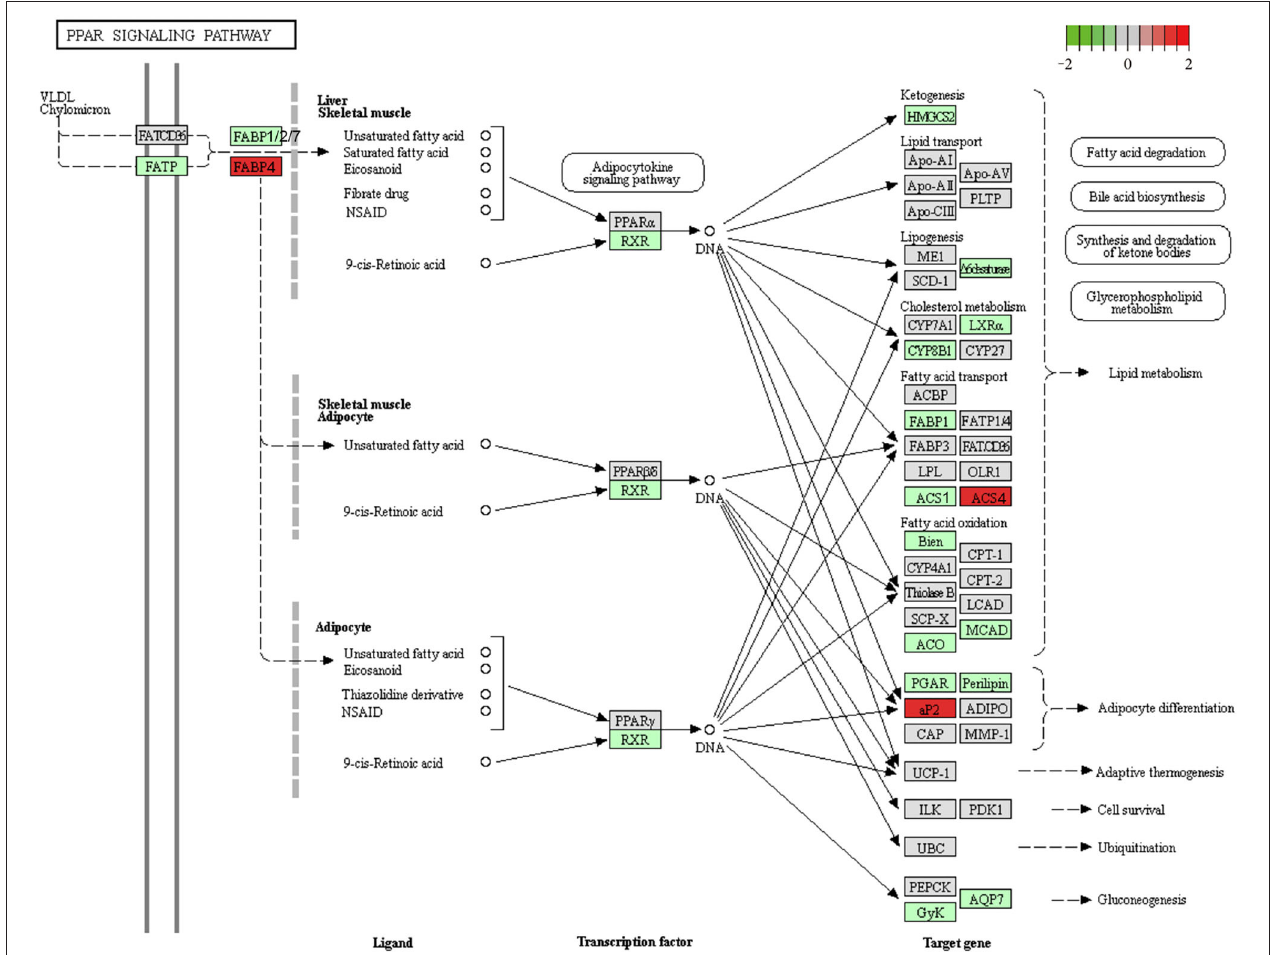
FIGURE 5 | Downregulation of the PPAR signaling pathway in IUGR. We obtained the original Figure 5 from the KEGG website (https://www.kegg.jp/kegg-bin/show_ pathway?map03320), and we made some modifications.